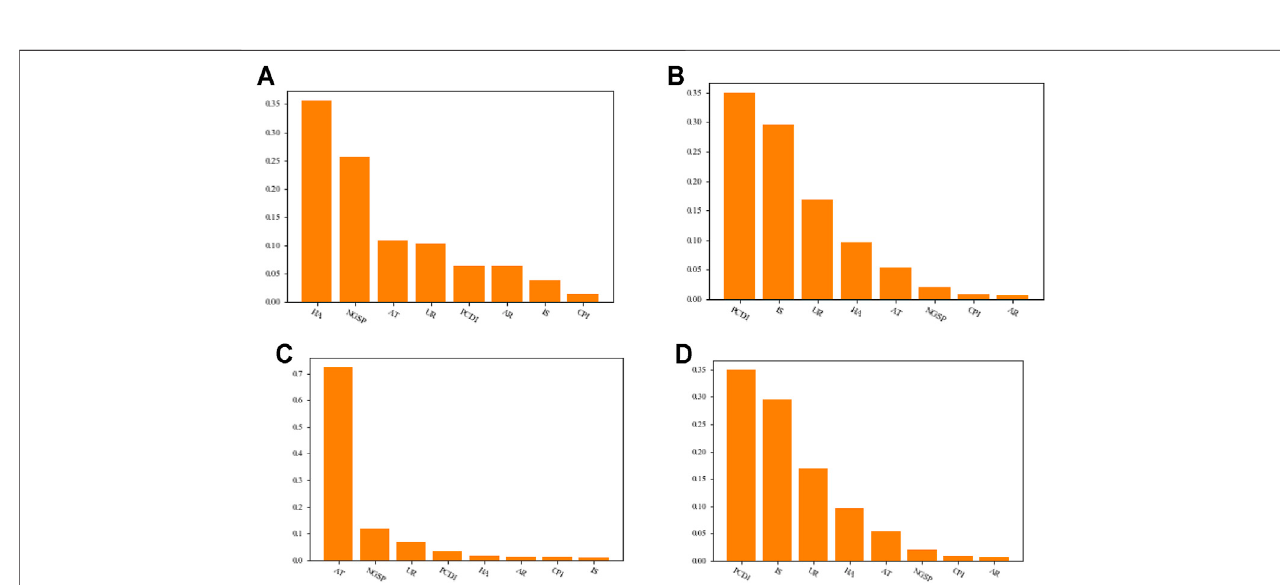
FIGURE 9 | Non-linear forecast results for urban household gas consumption.